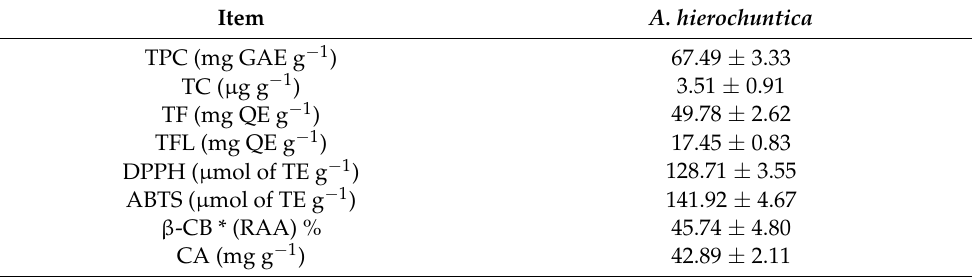
Table 1. Total phenolic content, total carotenoids, total flavonoids, total flavonols, and relative potential antioxidant activities of A. hierochuntica (mean ± SE), n =